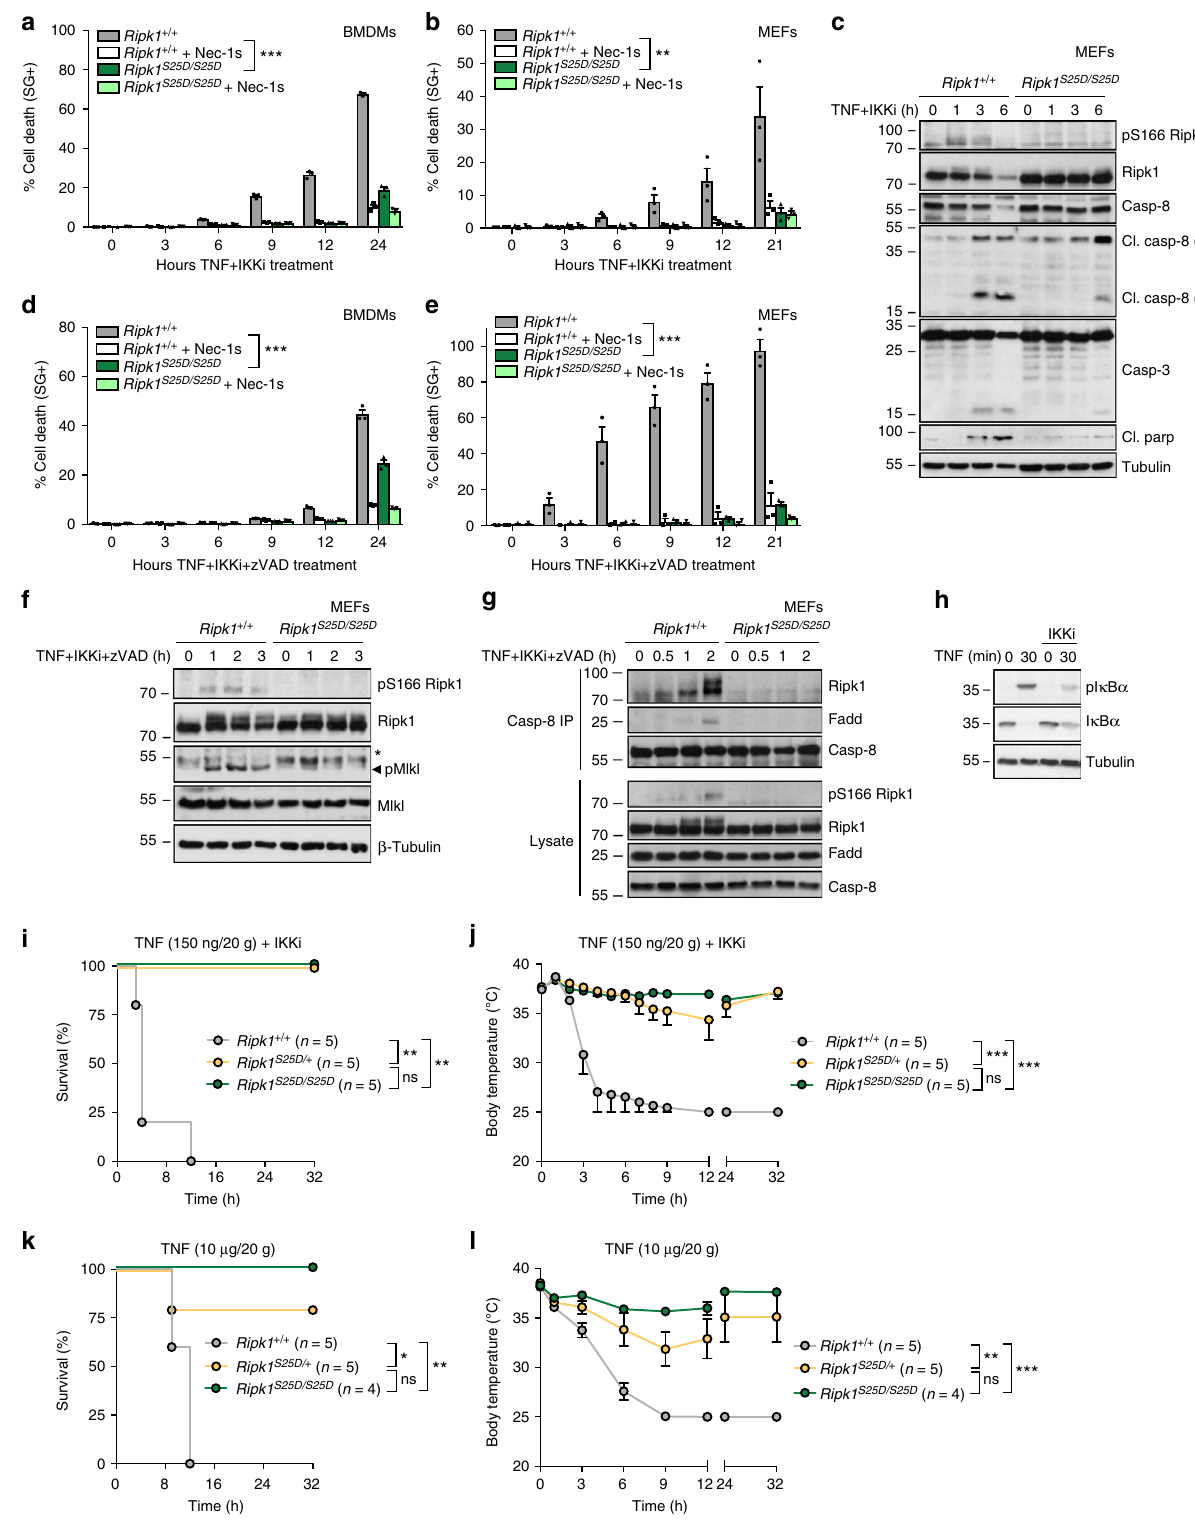
sections with H&E, TUNEL (cell death) and cleaved Caspase-3 (apoptosis) (Fig. 4d), and by the weight of the spleens (Fig. 4e). The rescue of the phenotype is also demonstrated by the nor- malization in the serum levels of the cell death marker LDH (Fig. 4e), of the pro-in fl ammatory cytokine IL-6 (Fig. 4g), and of the chemokine MCP-1 (Fig.